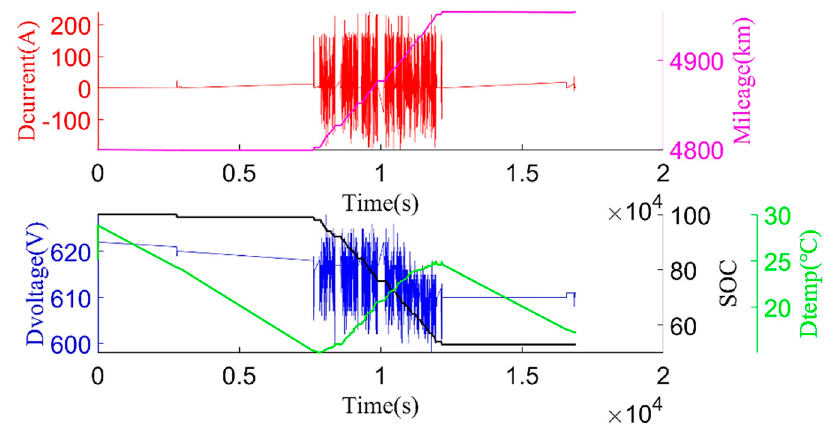
Figure 4. Example of discharging process: pack discharging current (Dcurrent), mileage, pack discharging voltage (Dvoltage), pack SOC, pack discharging temp (Dtemp).